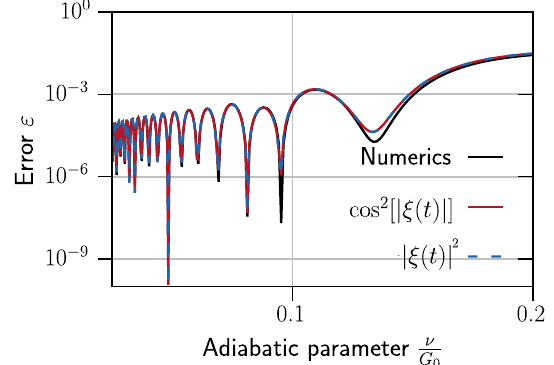
FIG. 10. Infidelity for STIRAP using Gaussian pulses. The approximate expression for the infidelity as given in Eq. (E5) agrees with exact numerics in the adiabatic regime, ν =G 0 < 1